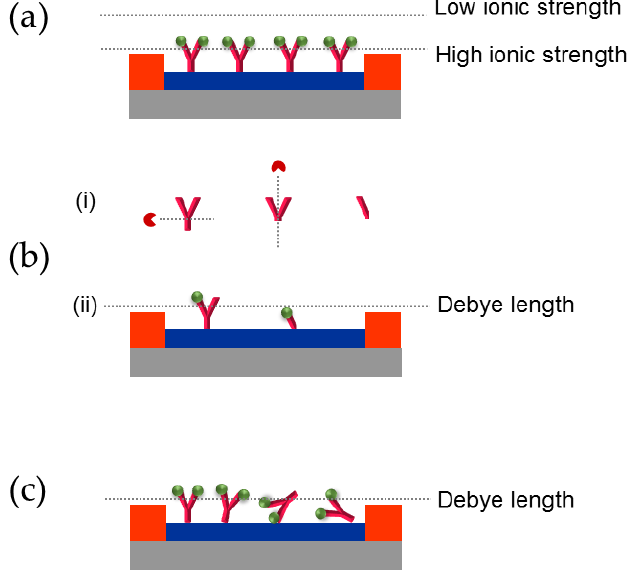
Figure 2. Antibodies (Y shape) immobilized on the gate region. Antigens (spheres) are bound to antibodies and the dashed lines indicate the Debye length position. ( a ) The Debye length is dependent on the ionic strength of the electrolytic buffer and it increases with the reduction of solution ionic strength. A measurable analyte-binding may occur only within the Debye length; (b,c) show alternative methods for antigen detection in high ionic strength solutions, without sample desalting; ( b ) (i) the antibody was cleaved by enzymatic digestion; and (ii) the antigen was brought within the Debye length [40]; ( c ) a more realistic representation of antibody alignment on the surface of an immunoFET showing random orientation of antibodies relative to the sensing surface, implying that some analyte-binding may occur within the Debye length [42].